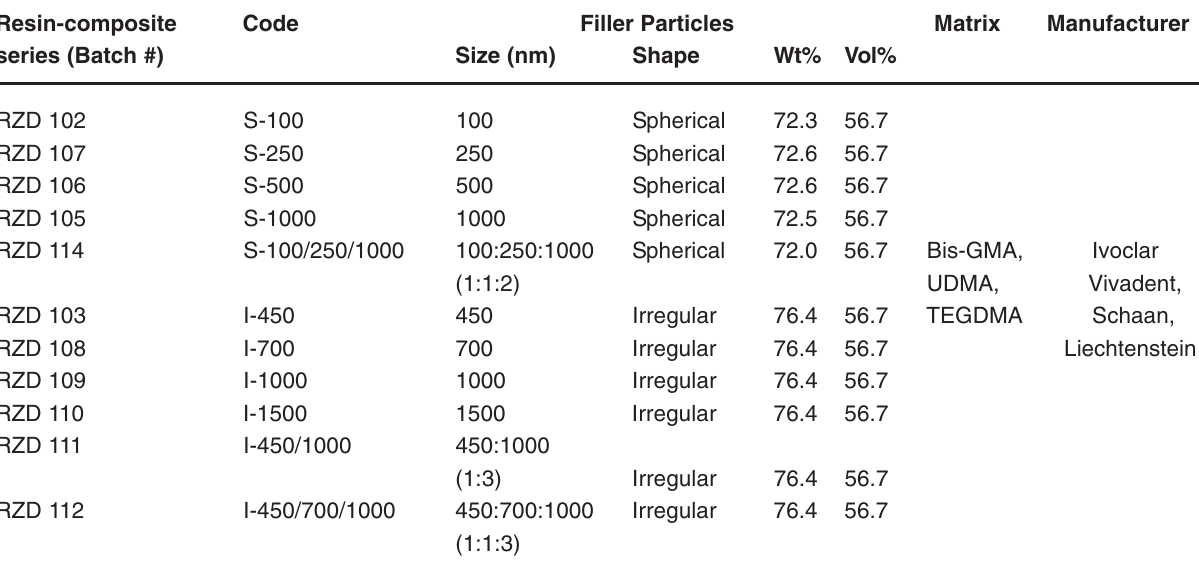
Table 1- Experimental composite series